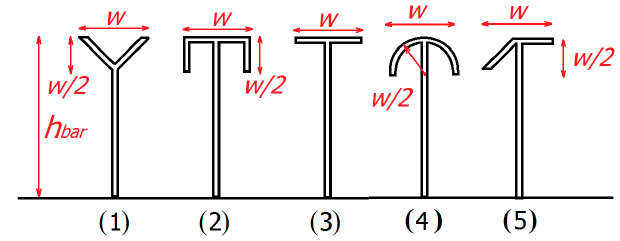
Figure 5. Barrier caps considered: ( 1 ) Y-shaped; ( 2 ) rectangular; ( 3 ) T-shaped; ( 4 ) cylinder with radius w/2; and ( 5 ) trapezoid-shaped.